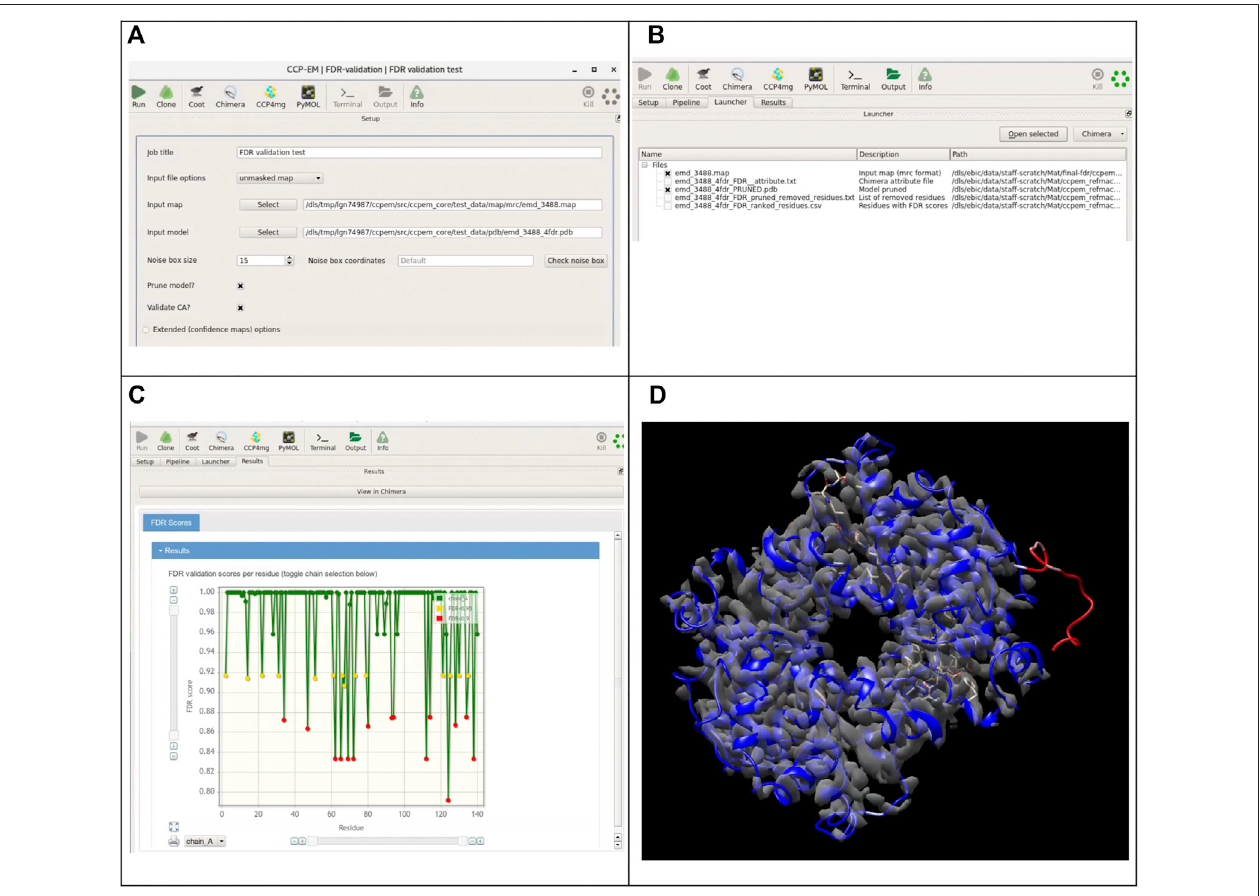
FIGURE 8 | Integration of the presented tool with the CCP-EM software suite. (A) Input interface for the FDR-validation task. The original map (preferably unmasked)oraprecalculated con fi dence map and amodel are required asinputs.Ifthe original map isprovided as input,a con fi dence map will be calculated internally. Usershaveaccesstotheadvancedsetupoptionsforcon fi dencemapjob. (B) Overviewofthelaunchertablistingtheoutput fi les. (C) ResultstabwiththeFDRbackbone scoresplotsforeachchain. (D) Resultingmodelscoloredaccordingtocalculatedcon fi dencescore,overlaidwiththecon fi dencemapinUCSFChimera(accessible from the results tab of the CCP-EM